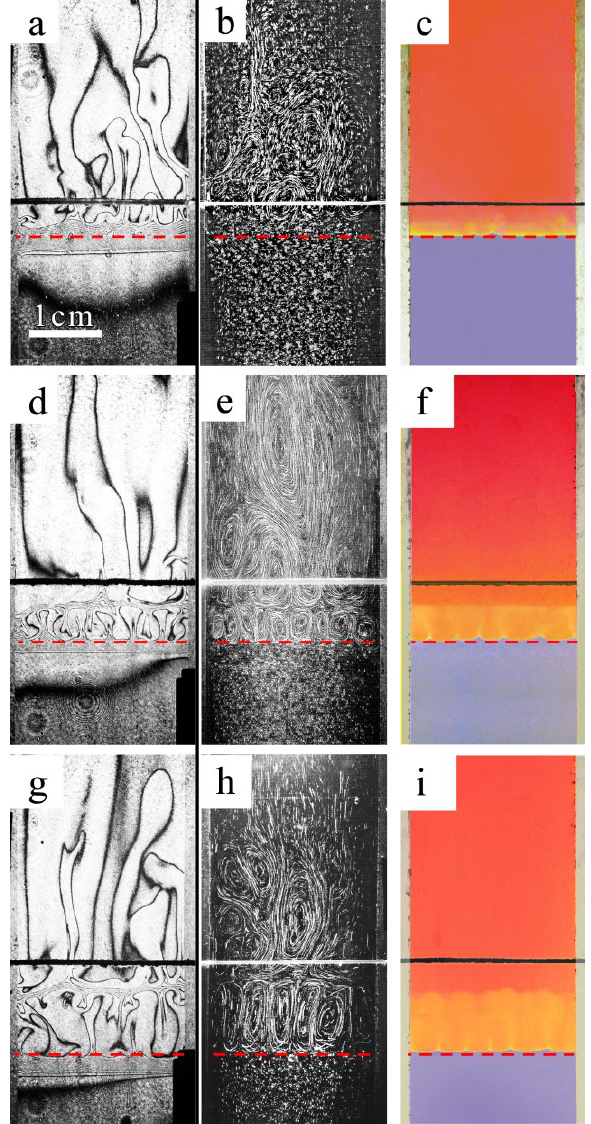
Fig. 2. Density field, f low structure and pH distribution obtained at deferent times after the experiment started. First row (a, b, c) - 300 s; second row (d, e, f)- 1100 s; third row (g, h, I) - 2250 s. The black horizontal line is the initial contact